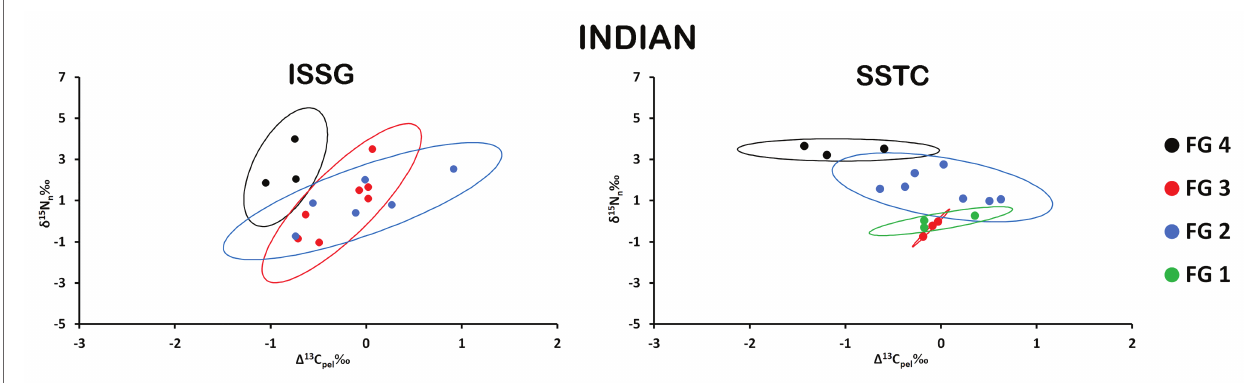
FIGURE 4 | Isospace of Δ 13 C pel and δ 15 N n including individual sample normalized values of neustonic zooplankton for biogeochemical provinces in the Indian Ocean: ISSG and SSTC. The maximum likelihood estimates of the standard ellipse areas (thick lines) for each FG is shown. FG 1 = detritivores; FG 2 = herbivores/ omnivores; FG 3 = carnivores; FG 4 = predators. Decreases in Δ 13 C pel reflect increases in raw δ 13 C values due to